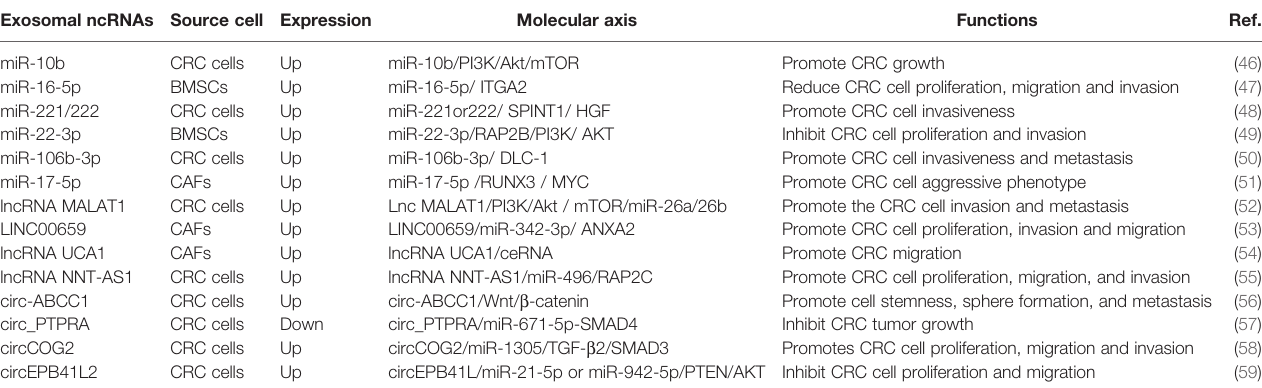
TABLE 1 | Roles of exosomal ncRNAs in the TME of CRC. Exosomal ncRNAs Source cell Expression Molecular axis Functions